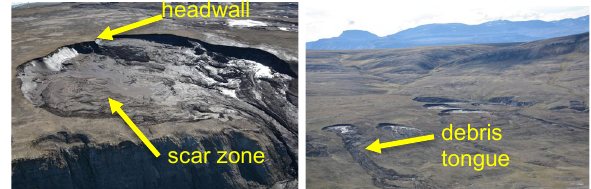
Figure 1 . Retrogressive thaw slump headwall, scar zone, and debris